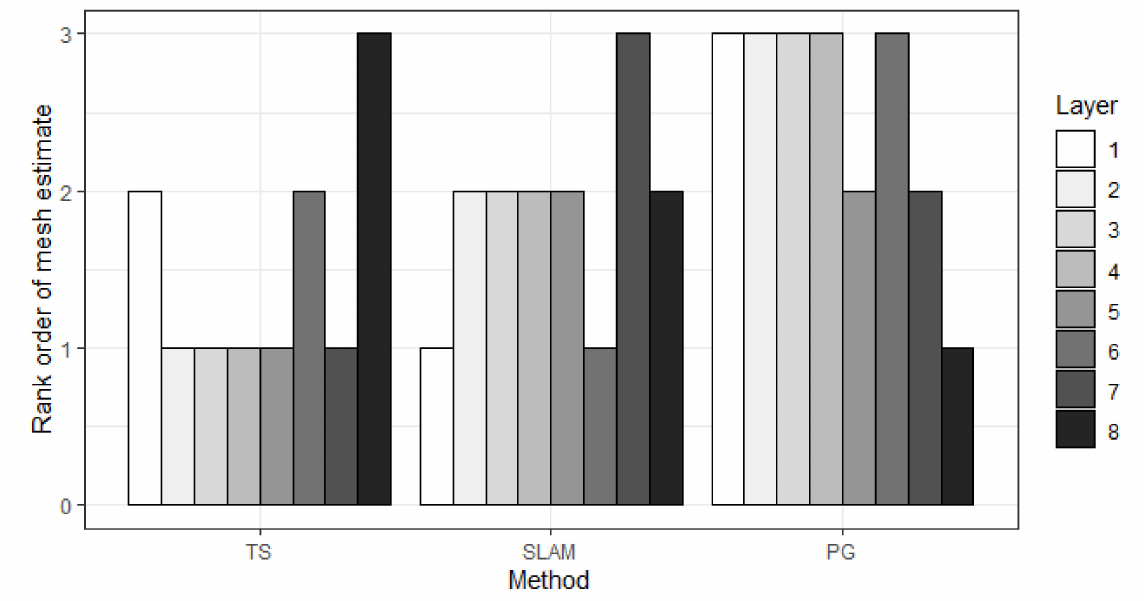
Figure 10. Rank orders of volumes for each deposit across methods modelled using triangulated